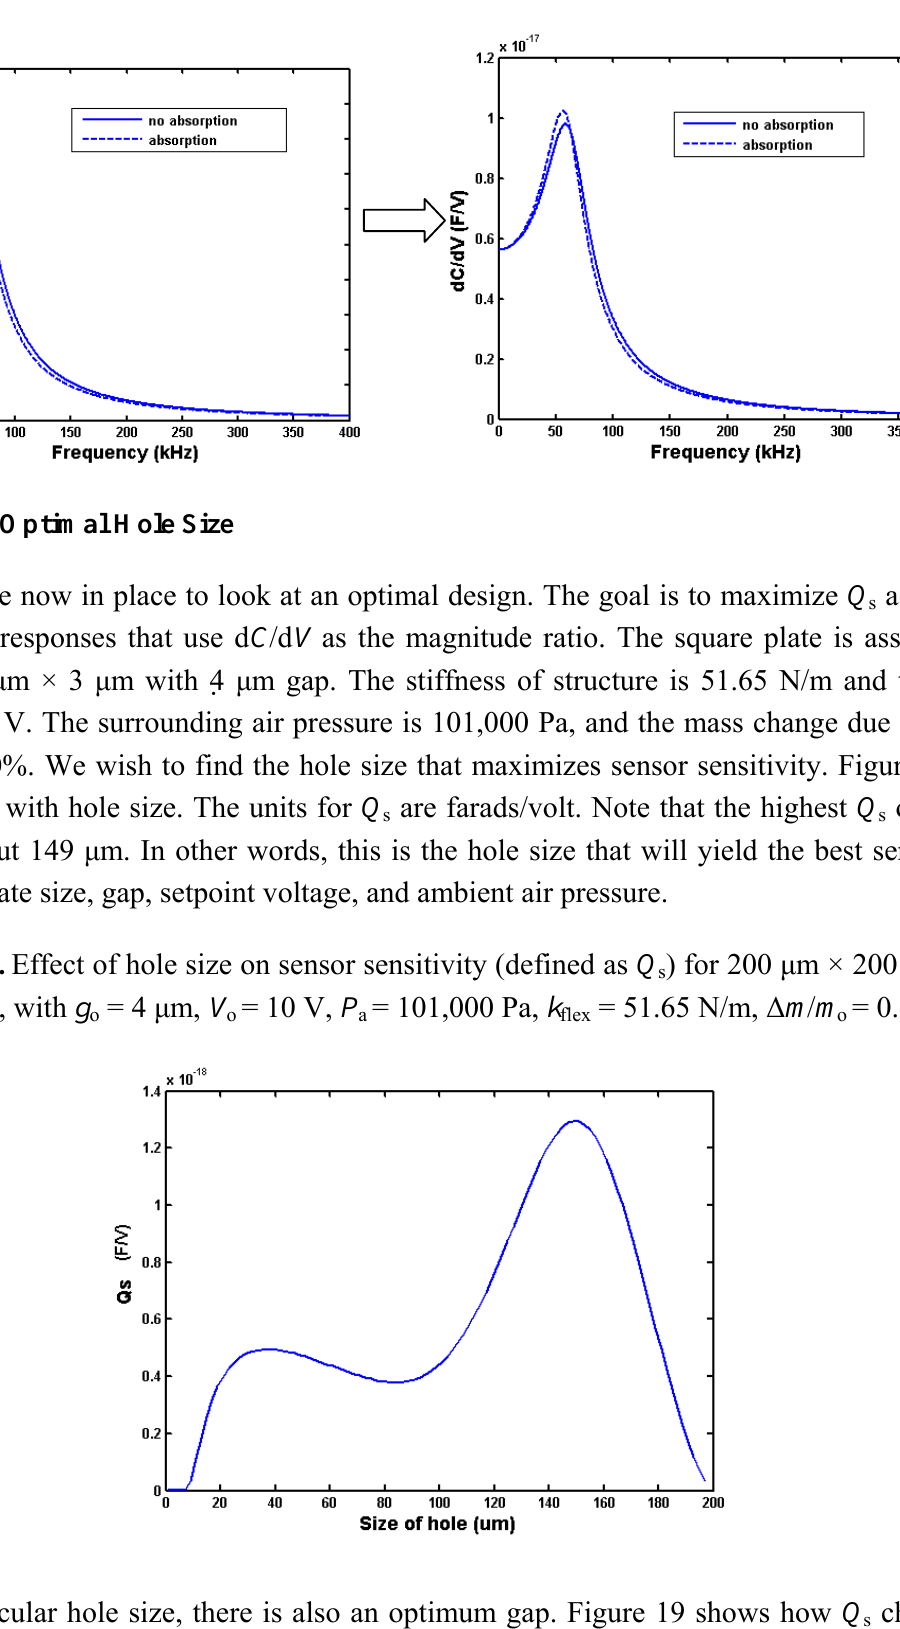
= 4 μ m, V = 10 V, P = 101,000 Pa, k o o a